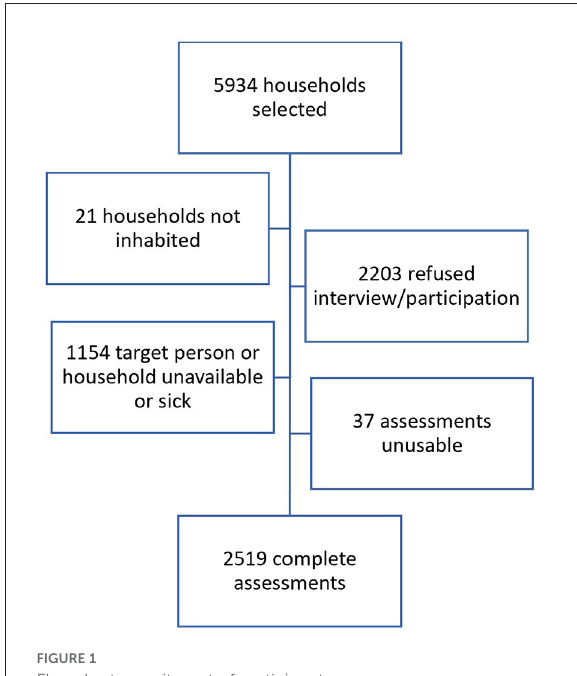
FIGURE1 Flowchart recruitment of participants.